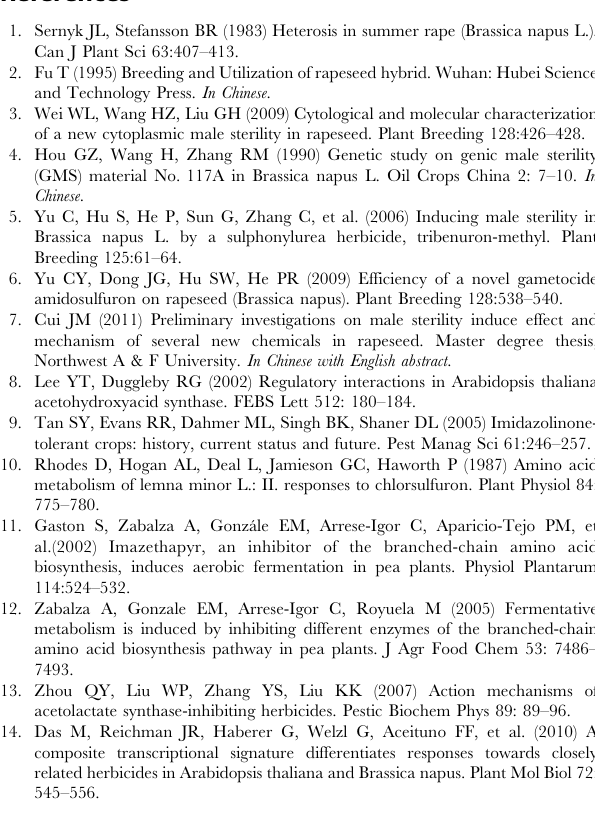
Table S1 Differentially expressed protein spots in tissues between the Mes-treated and the control plants. Table S2 Identities of differentially expressed proteins by PMF analysis. Table S3 Corresponding homologues of the 23 unknown